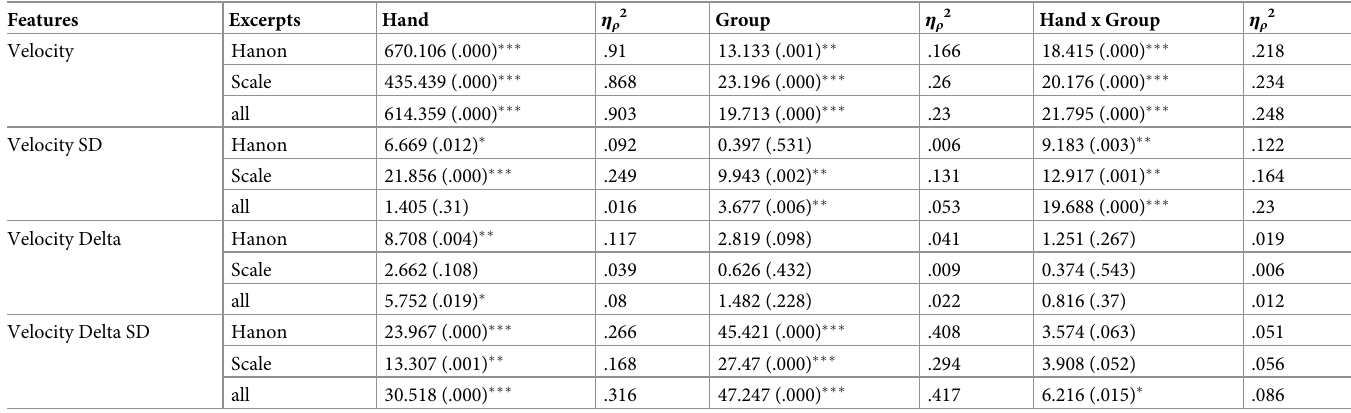
Table 4. F-statistics and p- values for dynamic